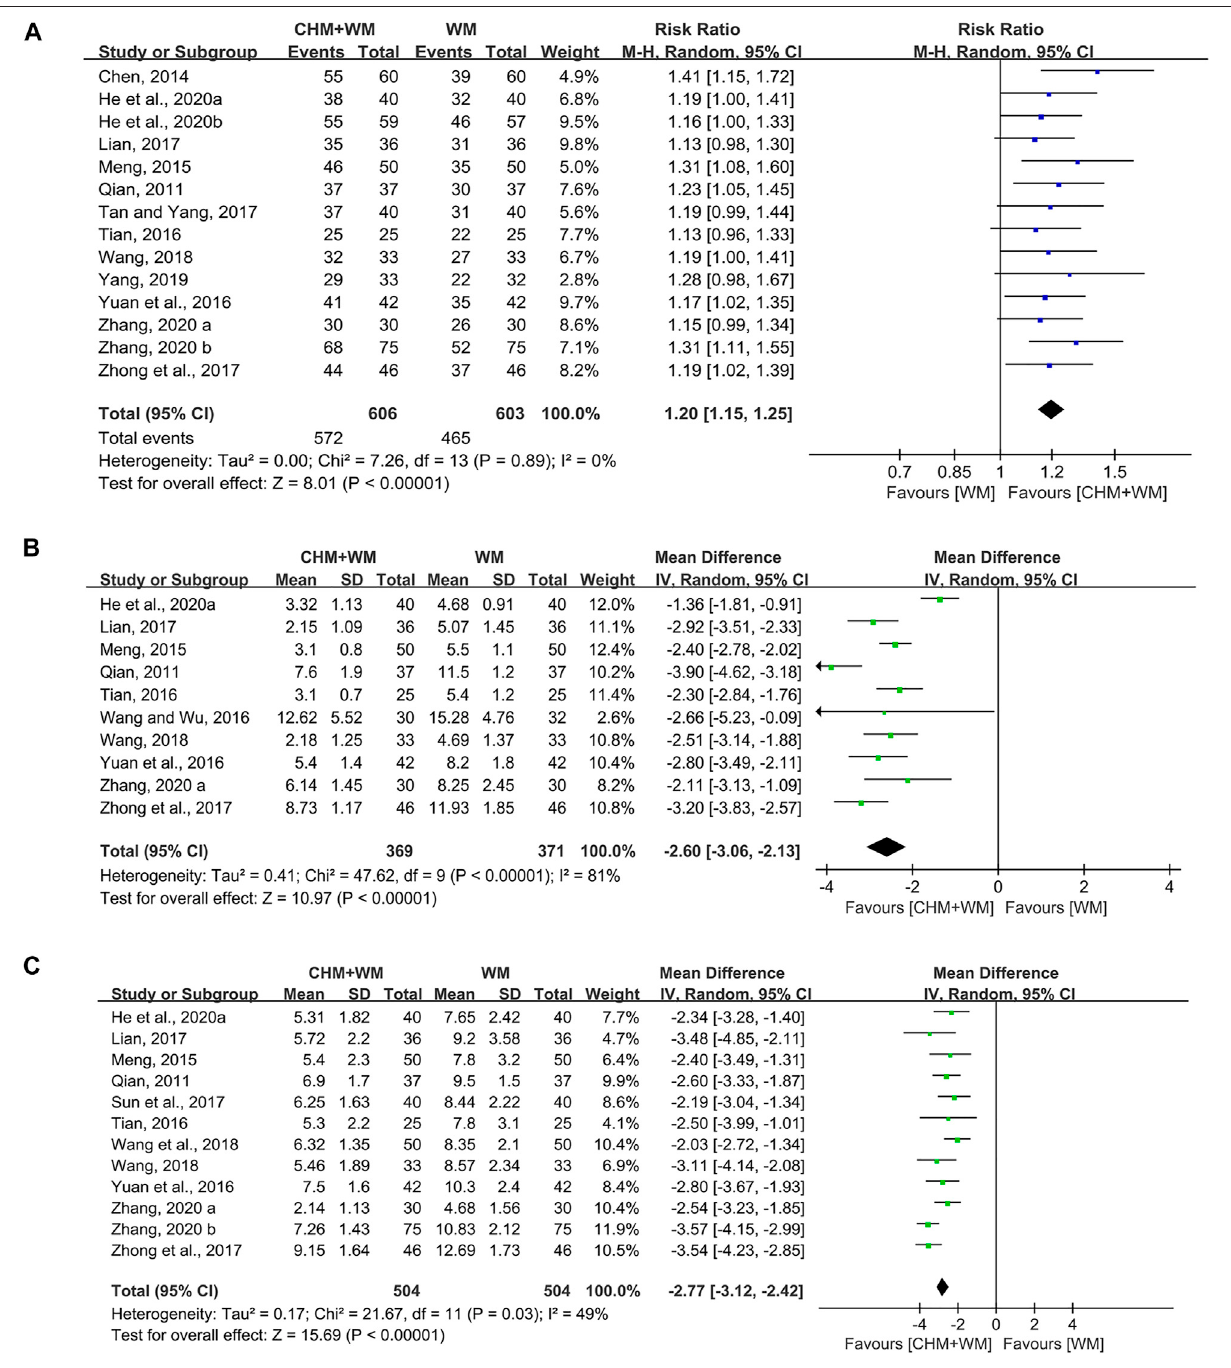
Frontiers in Pharmacology |